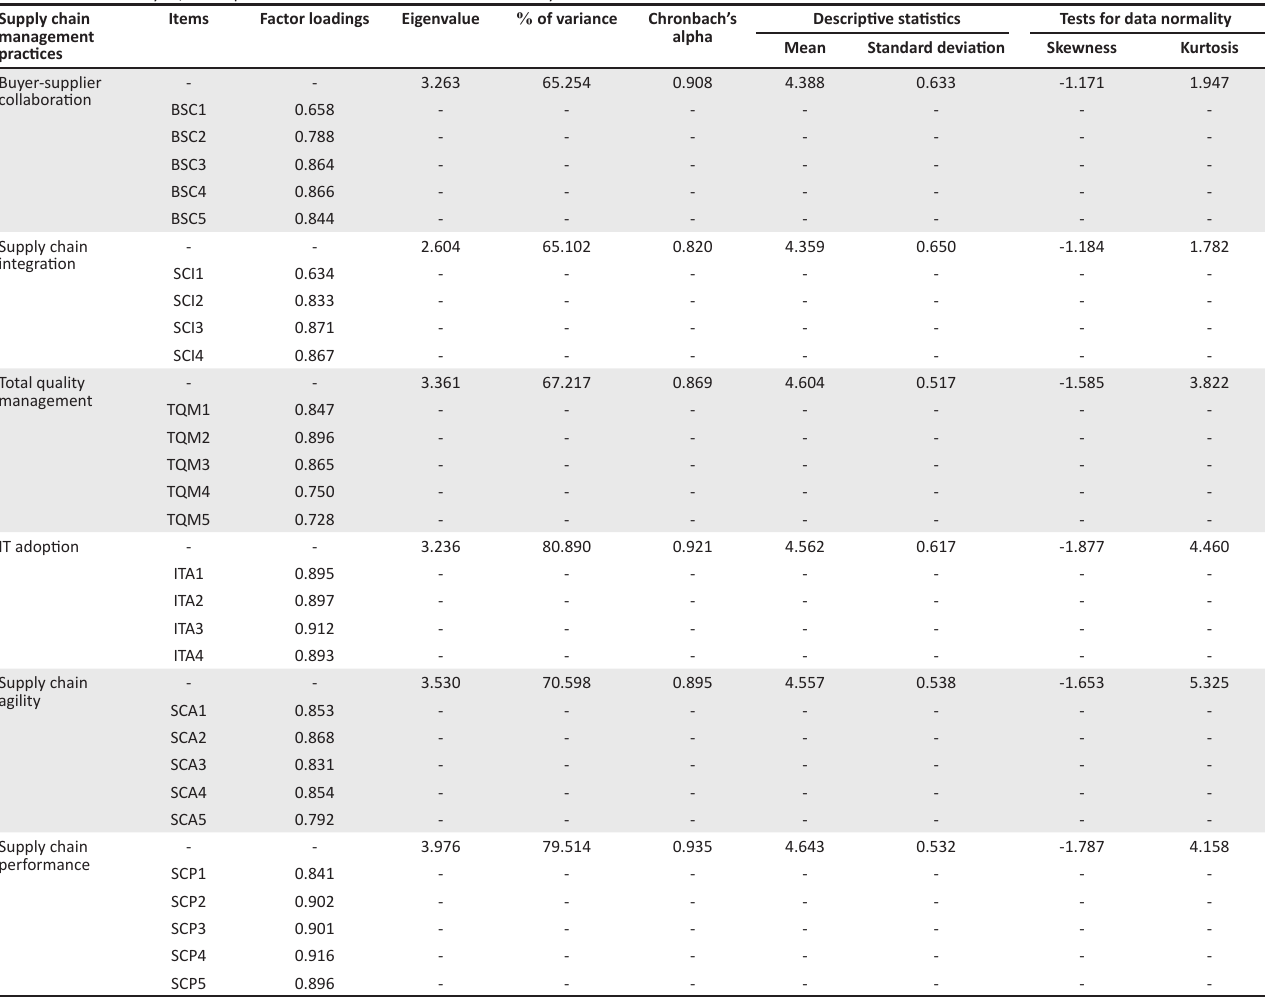
TABLE 2 : Factor analysis, descriptive statistics and tests for data normality. Supply chain